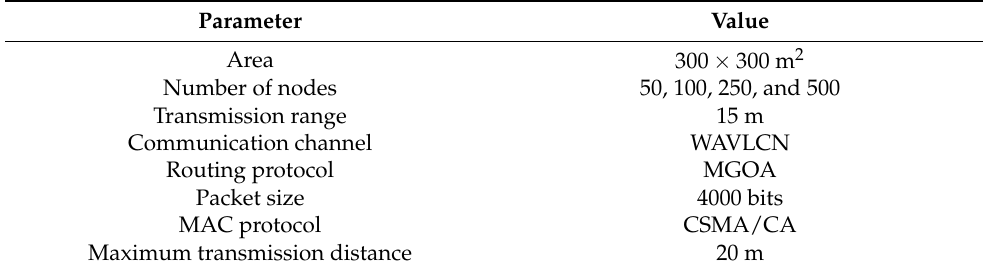
Table 2. Parameter specification of